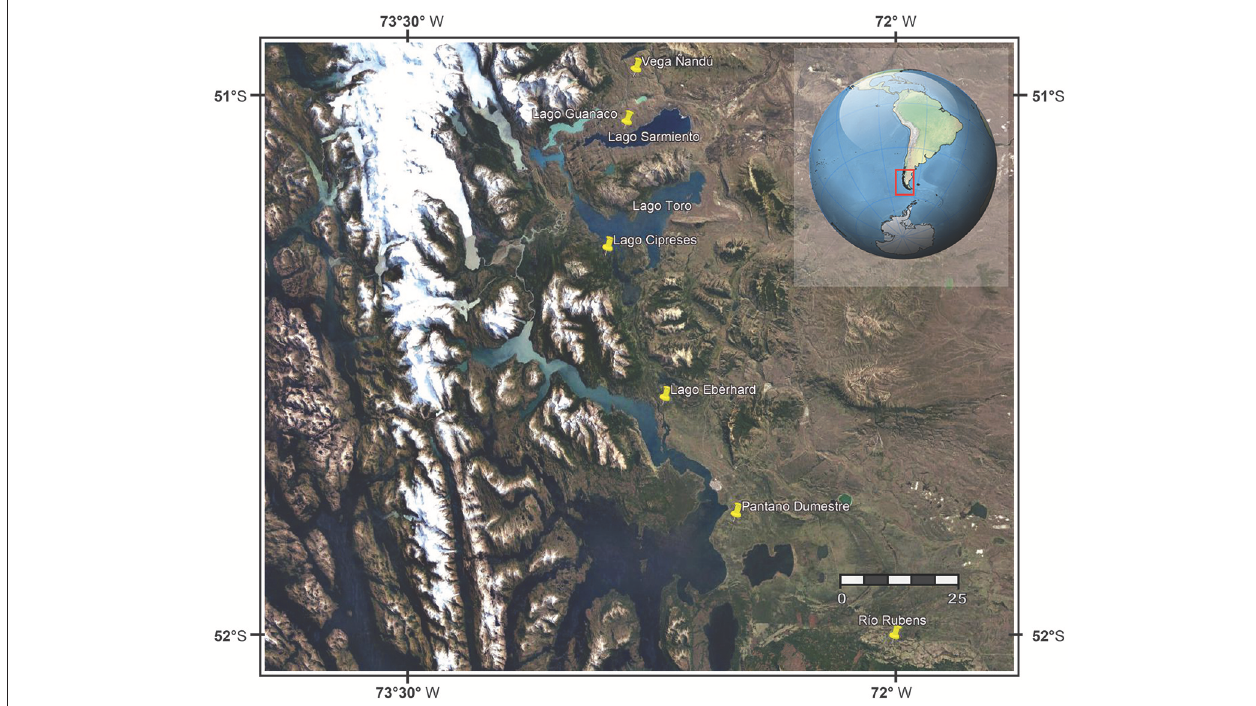
FIGURE 1 | Satellite image of the study area obtained from Google Earth showing the location of the sites discussed in the main